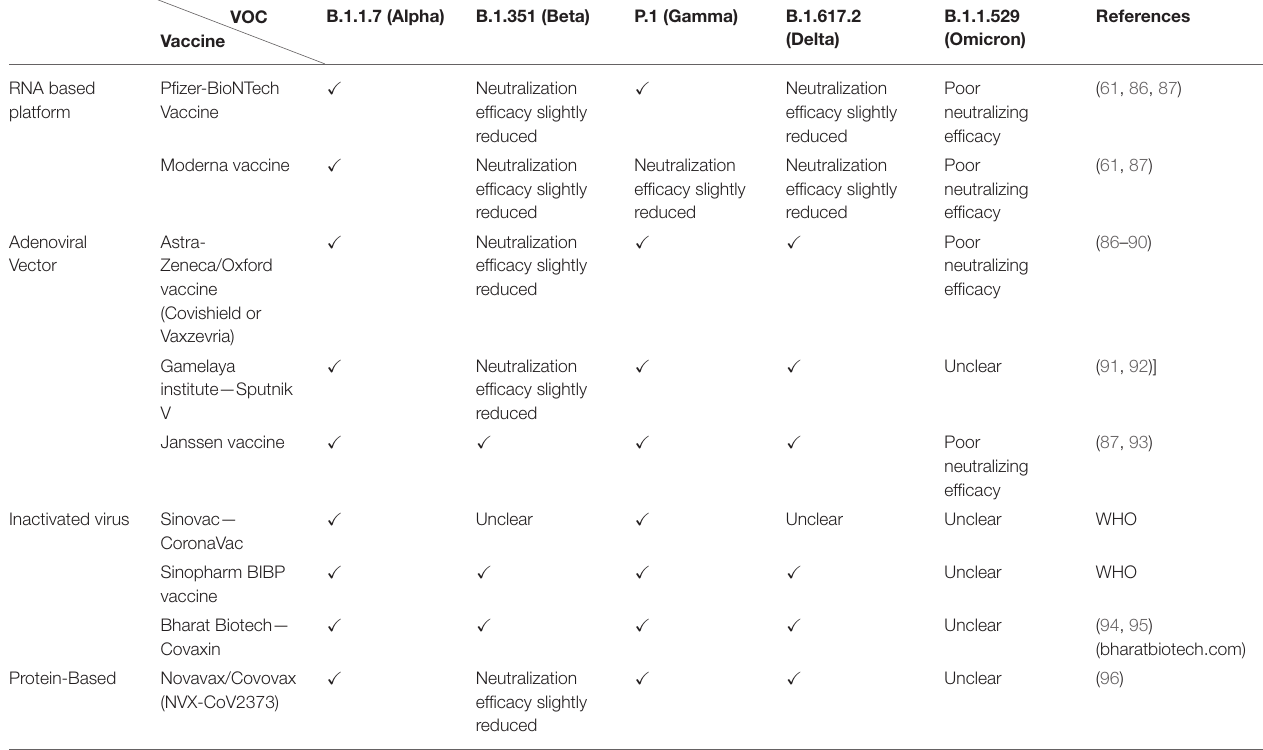
TABLE 4 | Impact of current VOCs on the neutralizing efficacy of